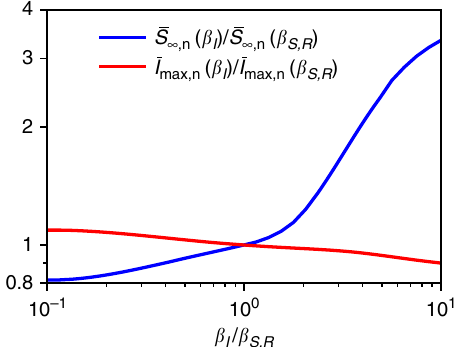
Fig. 2 Dependence of infection numbers on the amount of motion of infected persons. The maximal fraction of infected persons (cid:2) I max ; n and the fi nal fraction of susceptible persons (cid:2) S β β I / S , R , 1 ; n are shown as functions of where β I and β S , R are the rescaled inverse temperatures corresponding to the amount of motion of the infected and healthy persons, respectively. The plot corresponds to strong interactions with C si = 3 C sd = − 30. A decrease of the temperature, i.e., a reduction of the amount of motion of the infected persons, inhibits the